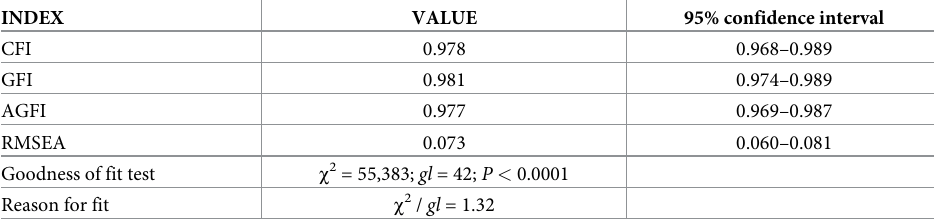
Table 5. Indices of goodness of fit of the exploratory unidimension to the model.